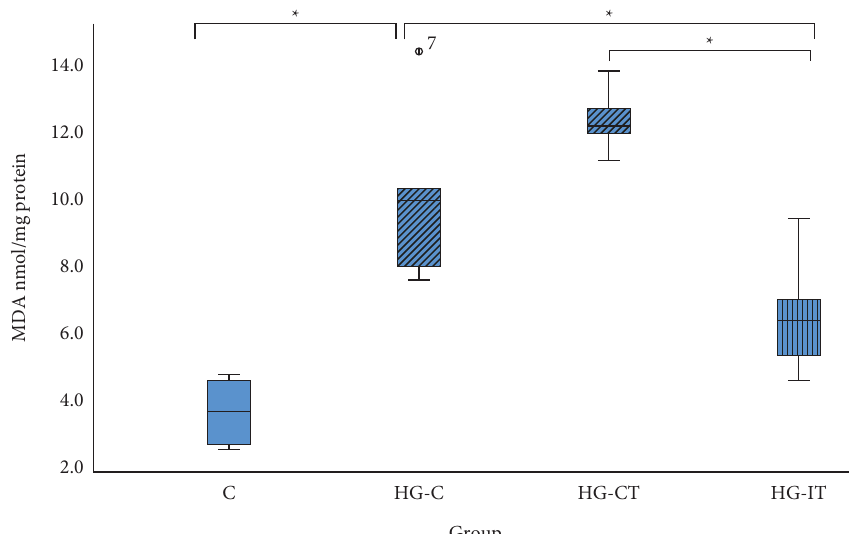
Figure 6: MDA concentration within each group. c: control group; HG-C: hyperglycemic control group; HG-CT: hyperglycemic rats that performed moderate-intensity continuous training (MICT); HG-IT: hyperglycemic rats that performed high-intensity interval training (HIIT). Te error bars represent the standard deviation of measurements. ∗ p < 0 . 05.